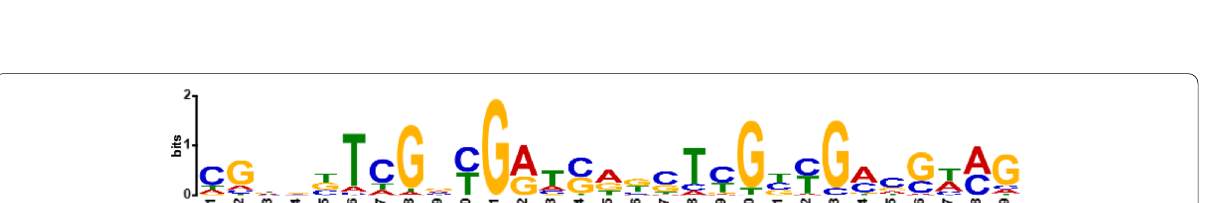
Fig. 2 Sequence logos for the identified common promoter motif, MTF1 of M . colombiense CECT 3035 genes. The analysis was carried out using the MEME